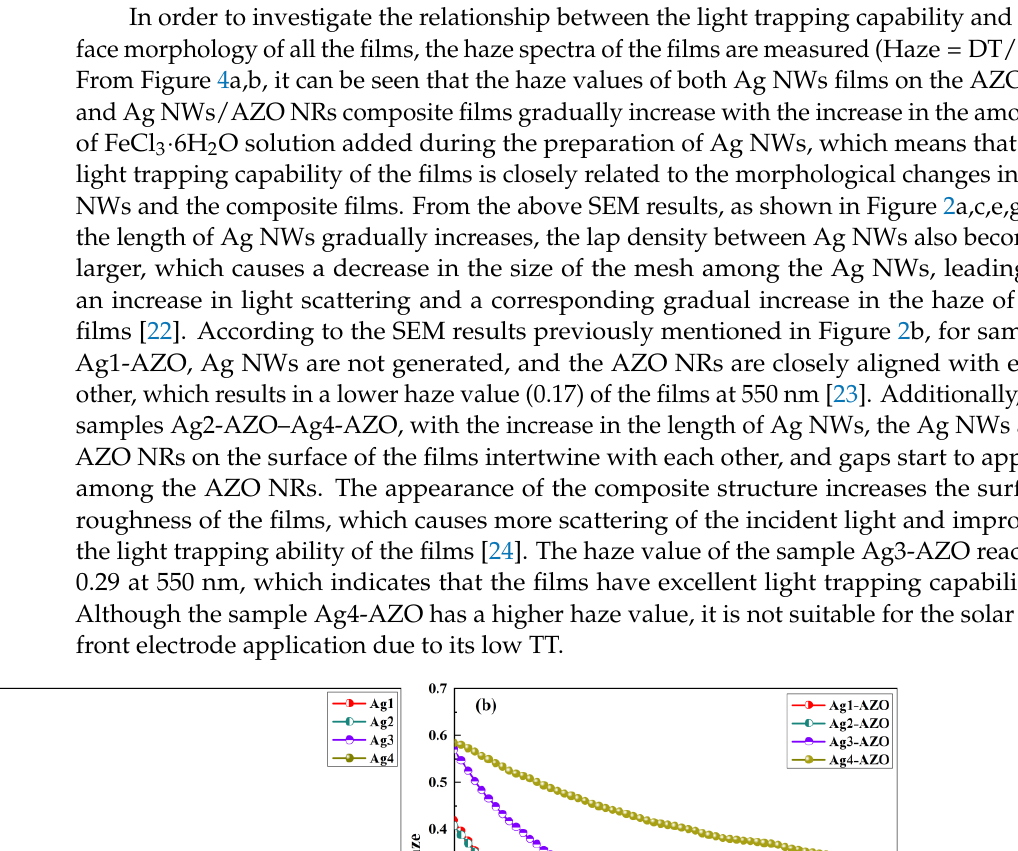
Figure 3. TT and DT spectra of ( a ) Ag NWs films on the AZO SL and ( b ) Ag NWs/AZO NRs com- posite films.